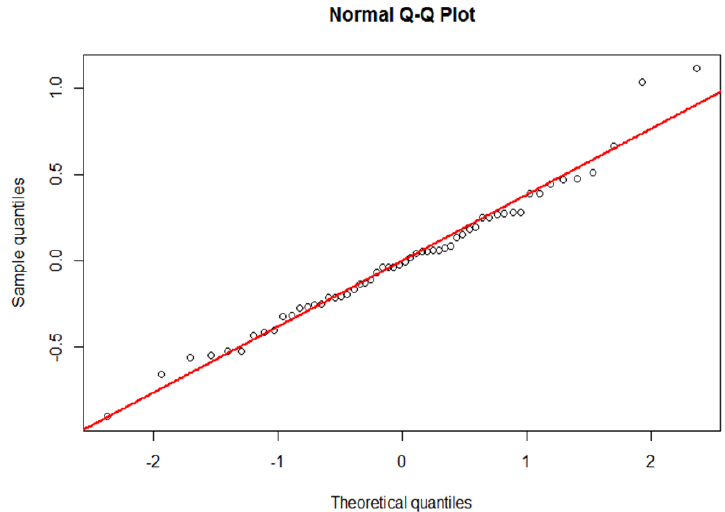
Figure 5. Normal Q-Q plot of the point estimates of the random intercept of the multilevel model to visualize outliers.